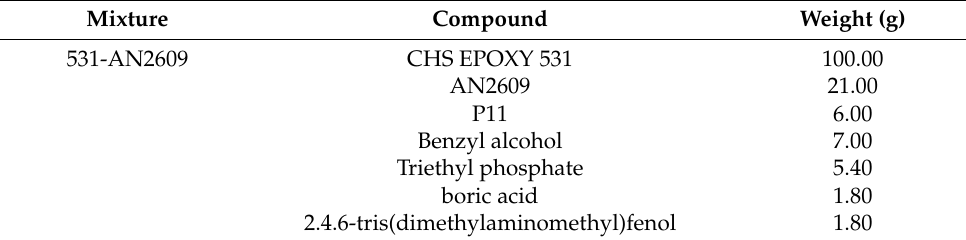
Table A17. CHS Epoxy 531 with AN2609